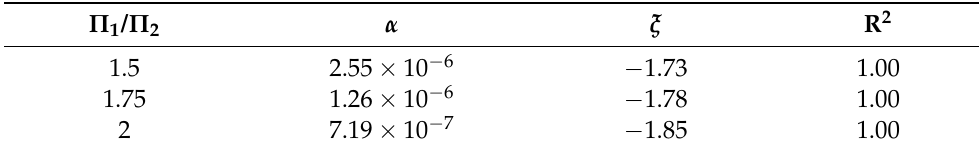
Figure 8. OLC Π 0 vs. Π 3 [26]. Table 5. Coefficients relating Π 0 to Π 3